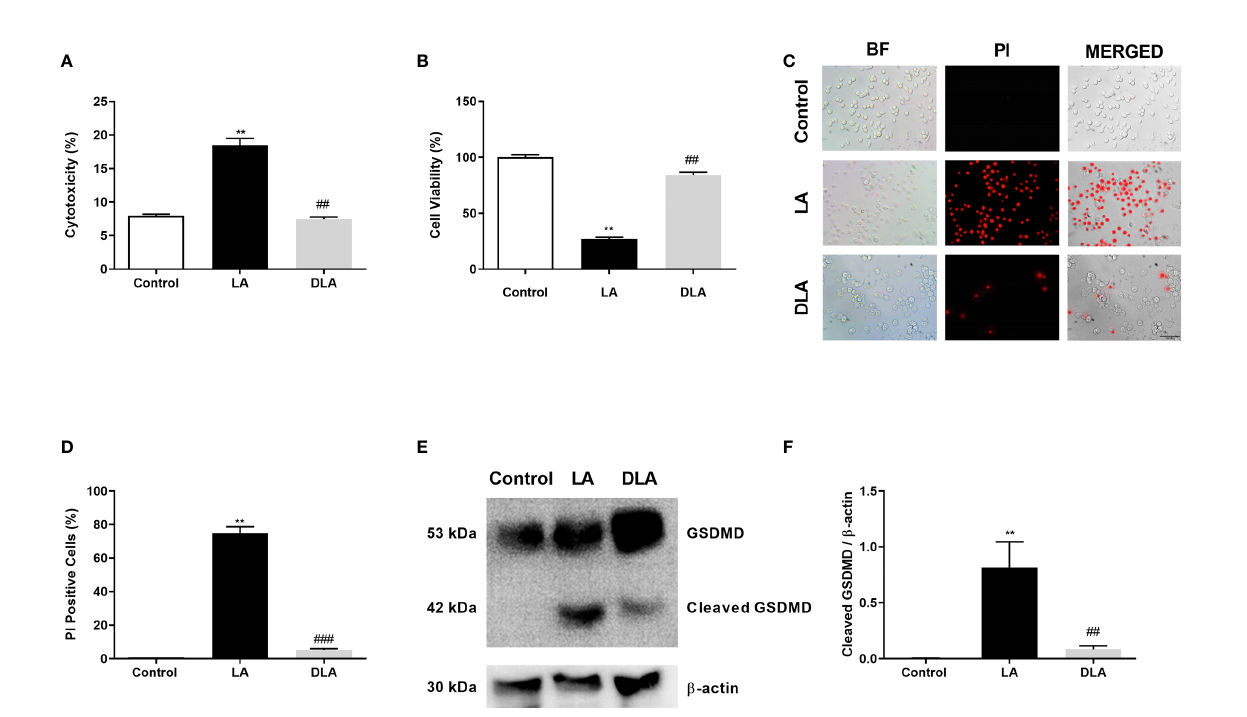
FIGURE 3 | DMF attenuated GSDMD cleavage and subsequent pyroptotic cell death. N9 microglia were pretreated with DMF (10 m M) for 1h, primed with UP-LPS (1000 ng/ml) for 4 hours, and followed by ATP (5 mM) for 1 hour. DMF pretreatment inhibited NLRP3 in fl ammasome-induced GSDMD cleavage and pyroptotic cell death in N9 microglia. (A, C, D) Changes in pyroptotic cell death were evaluated with the LDH assay and PI staining (Red staining – PI). (B) The effect of DMF on cell viability was measured with the CCK-8 assay. (E, F) GSDMD expression and its cleavage were detected with Western blot. Data are presented as mean ± S.E.M, n = 5. **p < 0.01 compared to control and ## p < 0.01, ### p < 0.01 compared to LPS and ATP induced